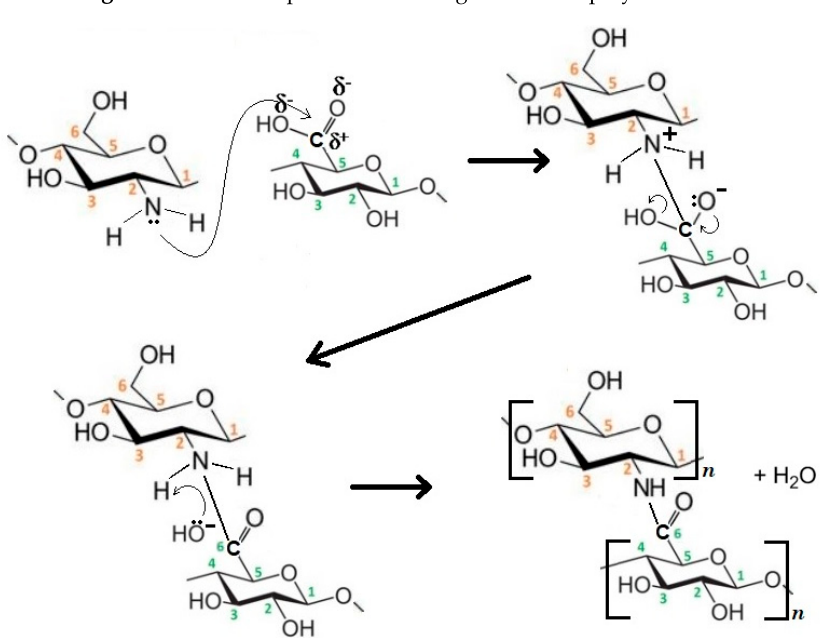
Figure 9. Copolymerization reaction mechanism of CNF-g-CH.